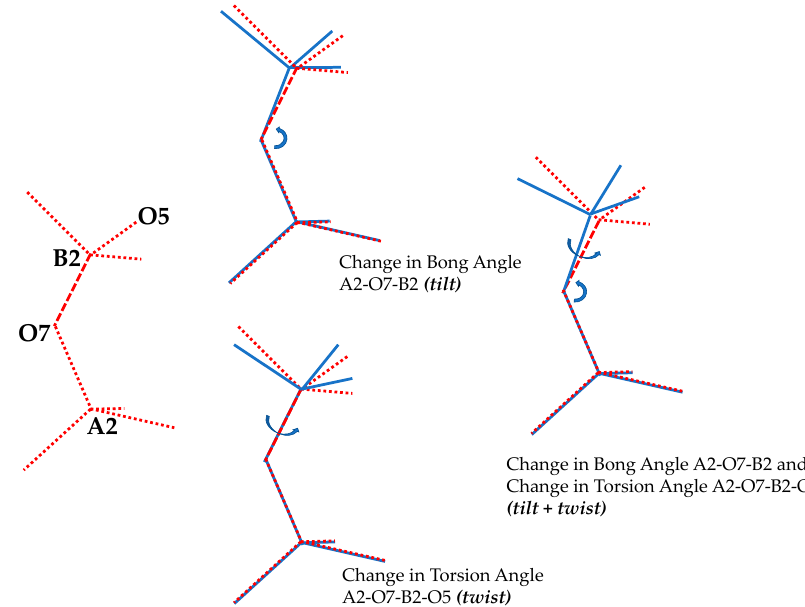
Figure 3. The effect of a change in As-O-B bond angle tetrahedral rotation as a ‘tilt’ compared to a change in ‘twist’ measured through a change in torsion angle tilt.